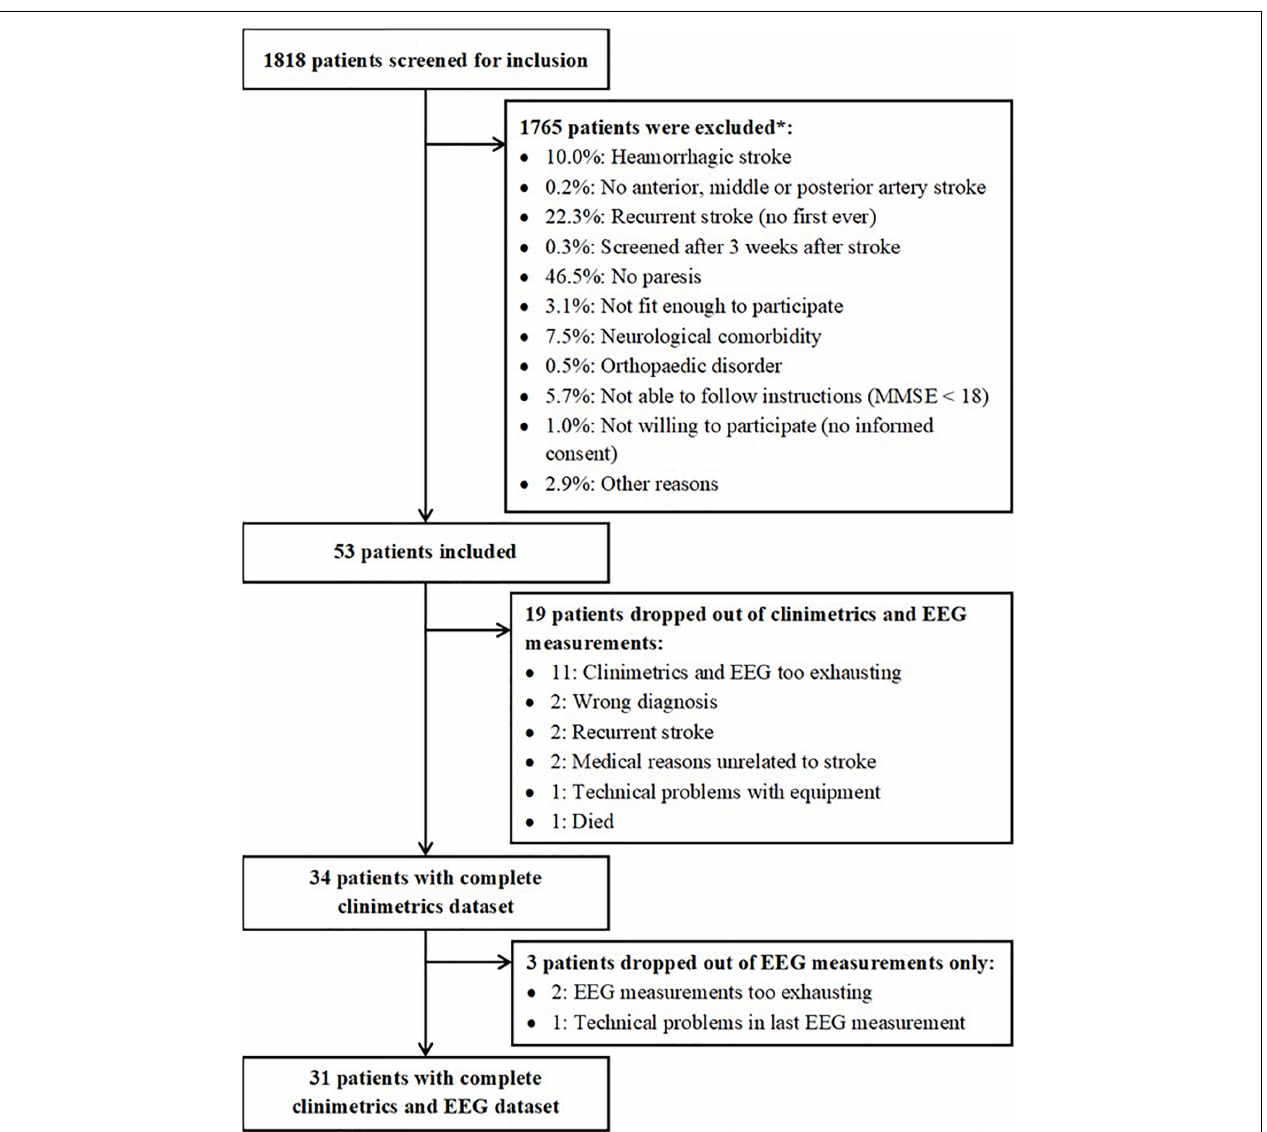
FIGURE 2 | Overview of patients who were included and excluded for the present study. *Estimations based on inclusion/exclusion information from one of the participating centers.